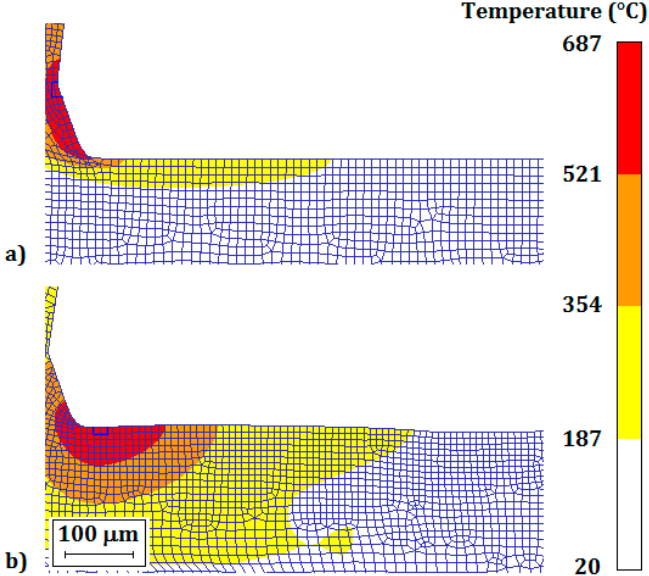
Figure 5. Prediction of strain distribution: ( a ) UP-F/V = 273 m/min, ( b ) UP-W/V = 273 m/min (UP-W: positive rake worn insert and UP-F: positive rake fresh insert).